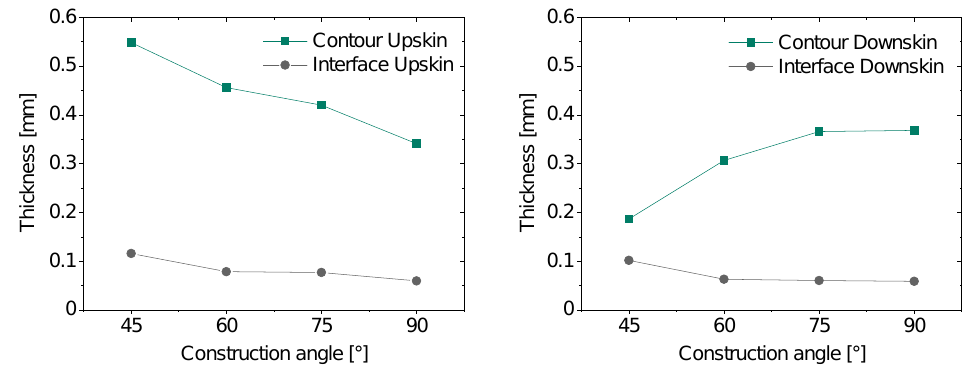
Figure 12. The sizes of the characteristic regions for different construction angles of the upskin surface ( left ) and downskin surfce ( right